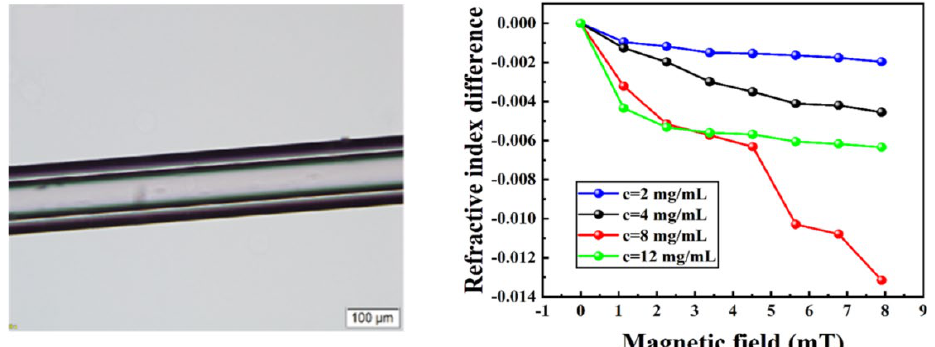
Figure 13. A microscope image and a relationship between different magnetic fields and refractive index with different concentrations based on PbS−QDs doped LCF (reprinted with permission from Ref. [99], 2022, The Optical Society).